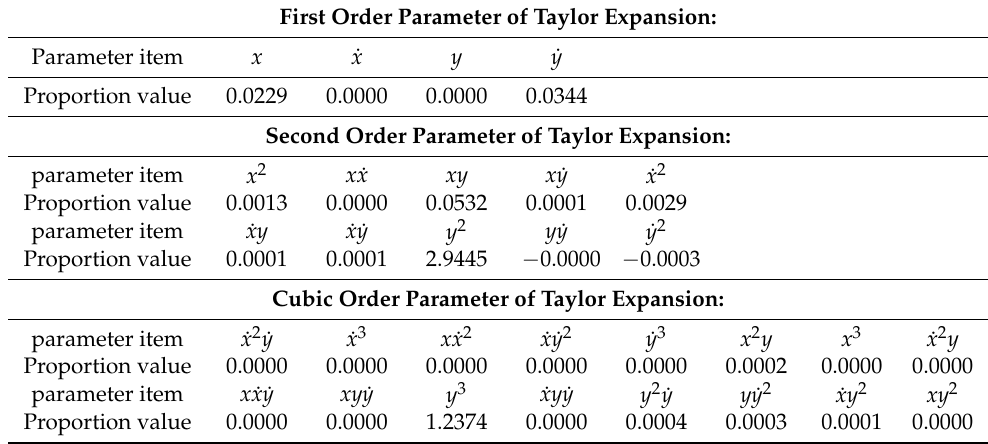
Table A2. Taylor series expansion of the dynamic rolling force in the vertical direction. First Order Parameter of Taylor